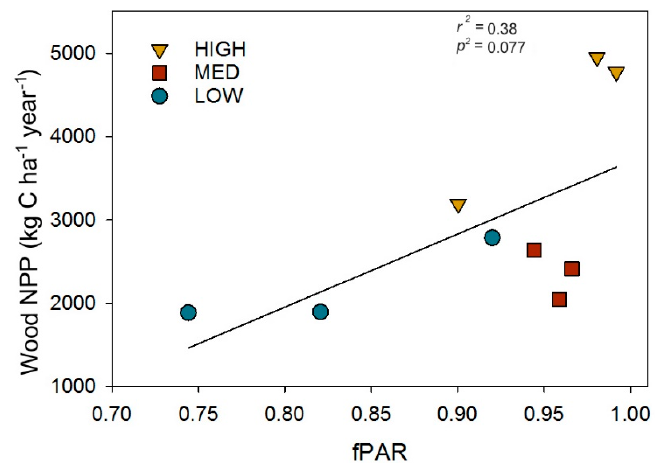
Figure 5. The post-recovery (2016) relationship between the fraction of photosynthetically absorbed radiation (fPAR) and wood net primary production (Wood NPP). Data points are for individual plots.